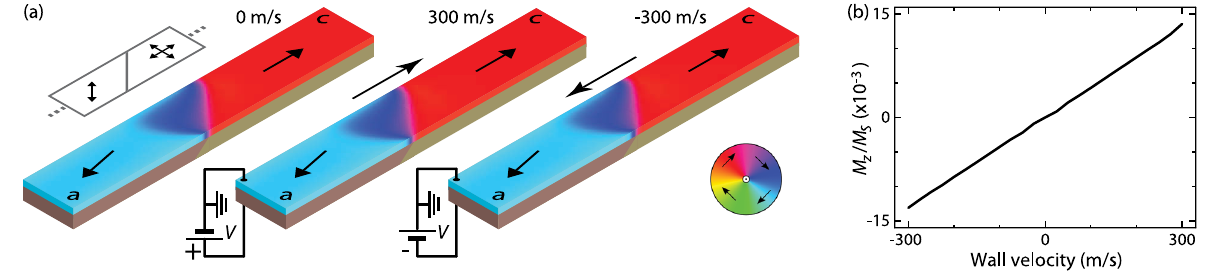
FIG. 6. Micromagnetic simulations of magnetic domain-wall motion in a 200-nm-wide and 5-nm-thick Fe wire. The schematic in the upper left corner indicates the easy magnetic anisotropy axes in the nanowire. The shape anisotropy of the wire stabilizes a near-180° transverse magnetic domain wall in zero magnetic field, which is strongly pinned by an abrupt anisotropy boundary on top of a ferroelectric a - c domain wall. Fast motion of the anisotropy boundary in both directions results in an equally fast displacement of the transverse magnetic domain wall with only minor deformations of the internal wall structure. The data in (a) illustrate the magnetic 300 m = s and v − 300 m = s. The evolution of a small out-of-plane magnetization structure of the nanowire at rest and for v AB ¼ þ AB ¼ component with increasing domain-wall velocity is shown in